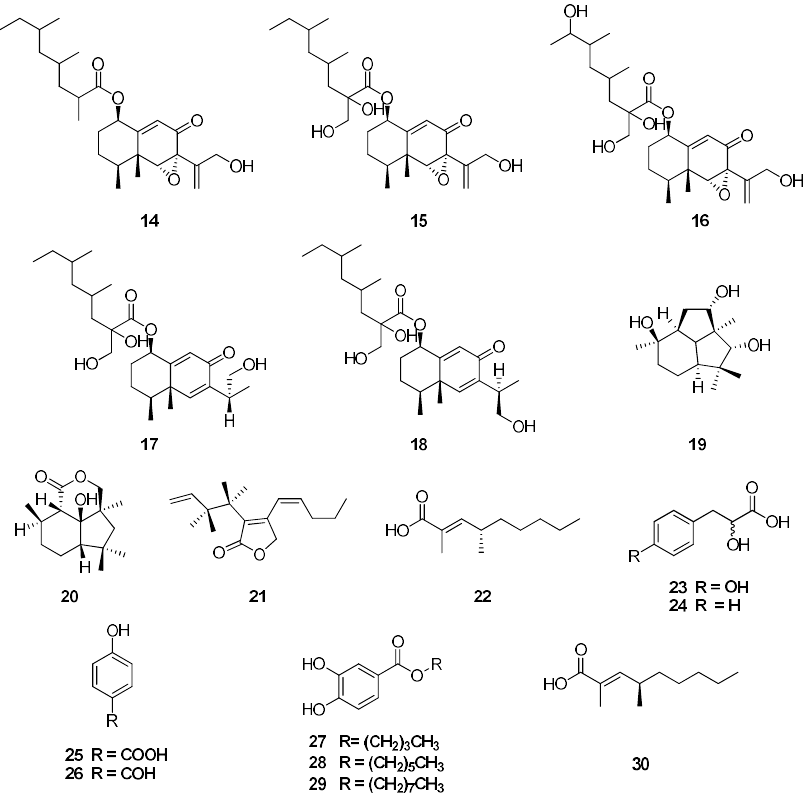
Figure 5. Compounds extracted from endophytes associated on A.